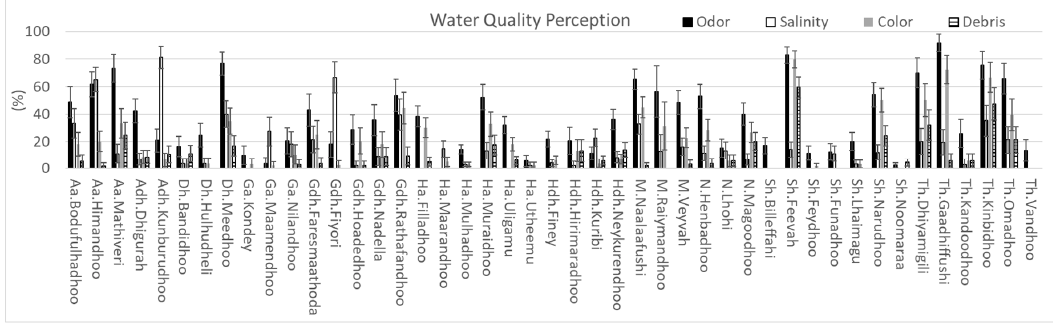
Figure 5. Groundwater quality perception of the respondents. The margin of error for a 95% confidence level is indicated as error bars.